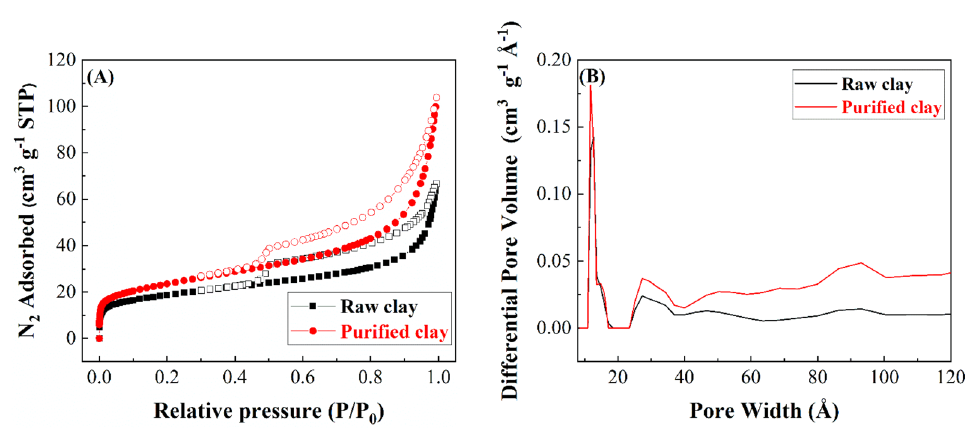
Figure 4. N 2 adsorption–desorption isotherms at 196 °C of raw and purified clay ( A ). Pore size distribution of the raw and purified clay ( B